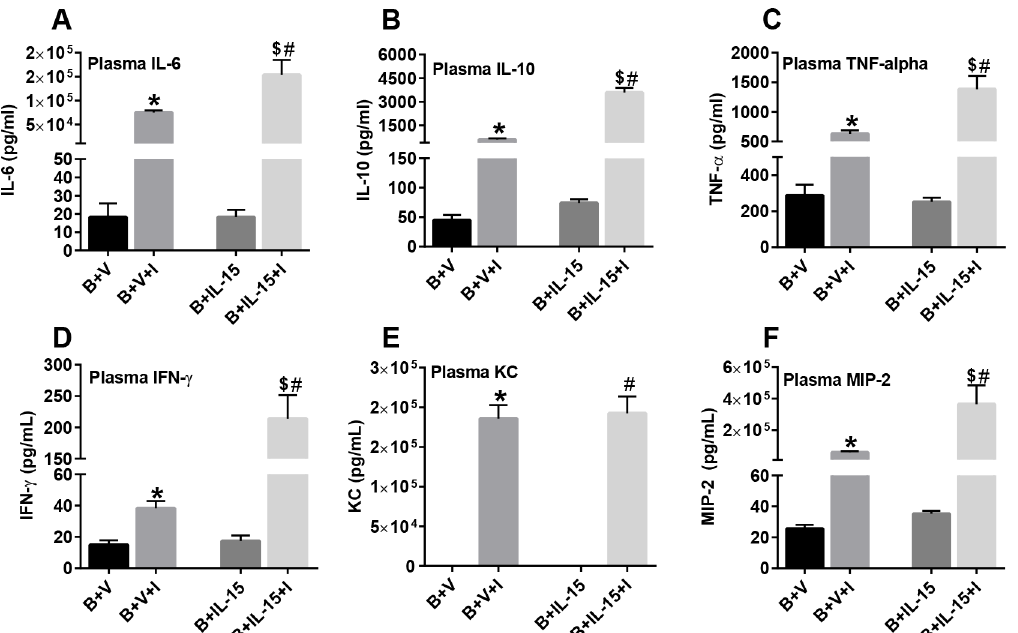
Fig 8. Plasma cytokine levels post intraperitoneal infection with Pseudomonas aeruginosa . Plasma cytokines including (A) IL-6, (B) IL-10, (C) TNF- α , (D) IFN- γ , (E) KC and (F) MIP-2 were measured using Bio-Rad Bio-Plex assay. n = 6 – 8 in each group and P < 0.05. * significantly different as compared to burn injury + vehicle treated group (B+V); #significantly different from burn injury + IL-15 SA treated group (B+IL-15); and $significantly different from burn injury + IL-15 SA treated infected group